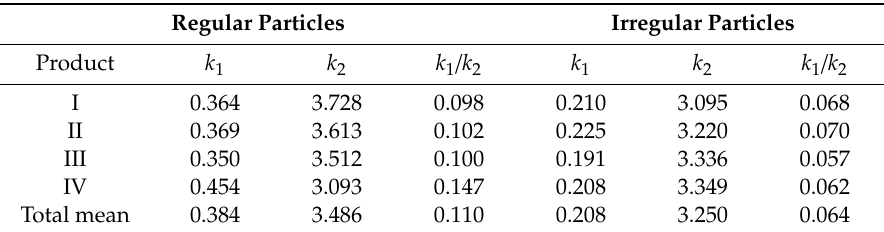
Table 2. Juxtaposition of the mean values of the shape coe ffi cients.